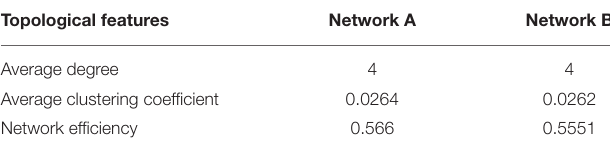
TABLE 1 | The topological features of Network A and